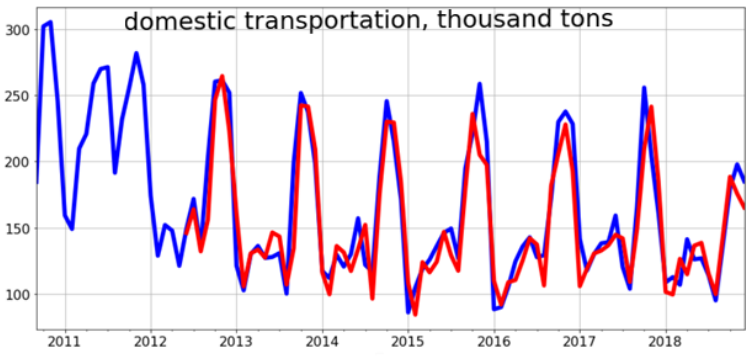
Figure 13. Checking the quality of the description of the predictive model of actual data. The predicted values of the model’s results are highlighted in red on the chart. Visual analysis reveals good data fit. This result can be confirmed by searching for the mean squared difference (MSE) between estimated and actual values (Figure 14). The obtained result— 1.105 shows that under the conditions of the study, it can be considered a permis- sible deviation. The high level of similarity between the present and predicted values is indicated by the high correlation coefficient— 0.920.